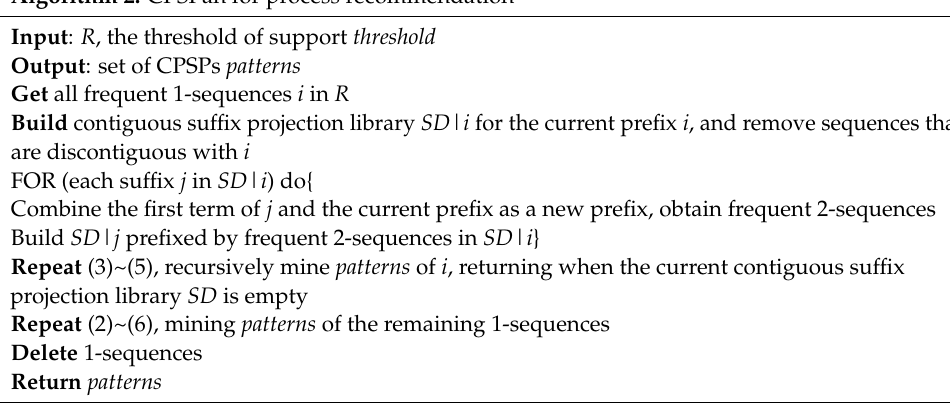
Algorithm 2. CPSPan for process recommendation